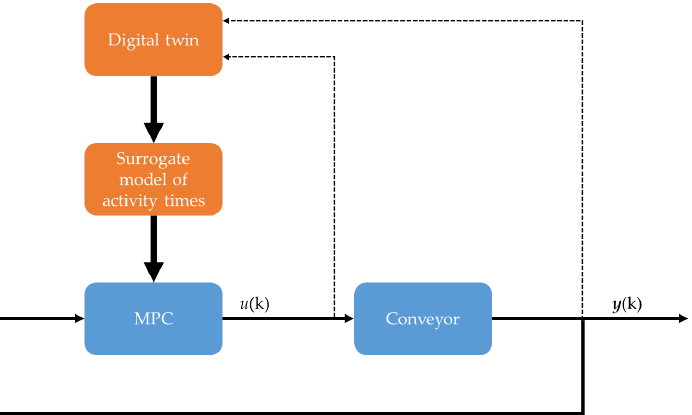
Figure 15. The scheme of the proposed surrogate model-based predictive controller (MPC). The model of the MPC is updated based on the information extracted from the digital twin.